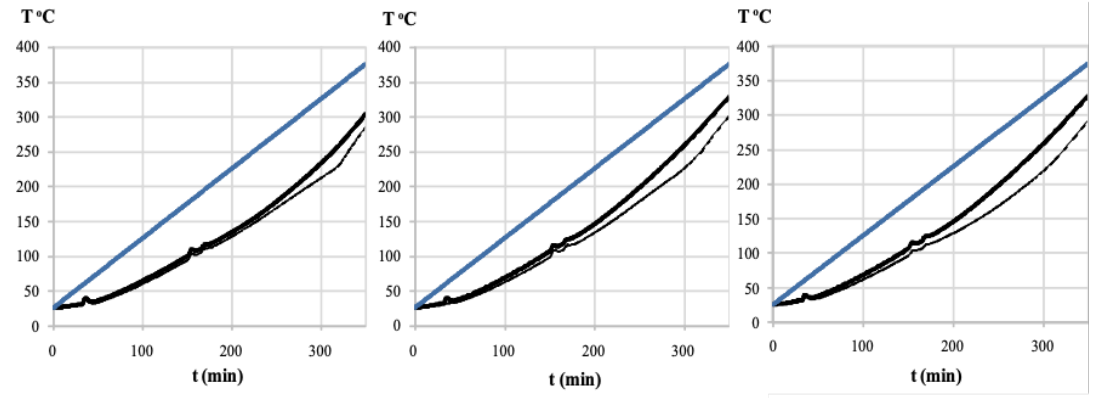
Figure 2. Time - temperature curves for OC, RAC 50% and RAC 100%.